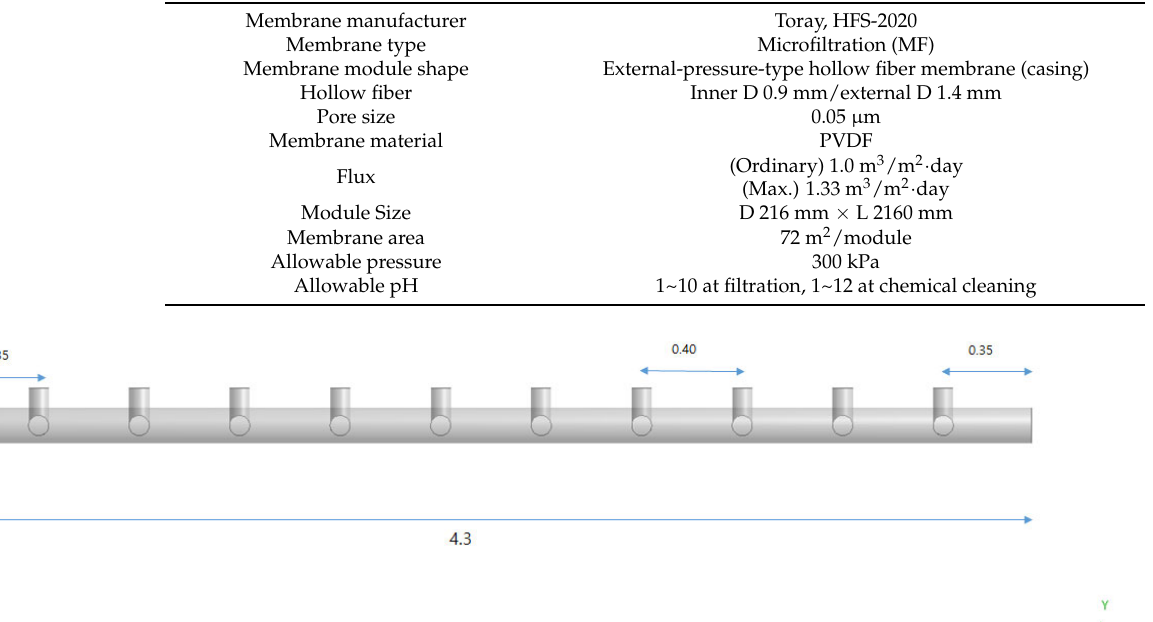
Table 1. Membrane module specifications.